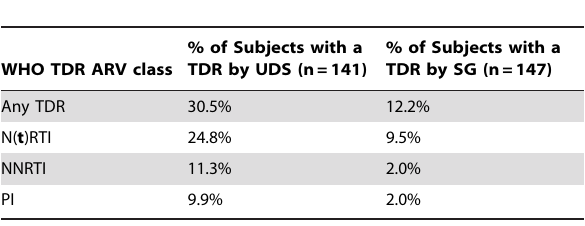
Table 2. Prevalence of transmitted drug resistance (TDR) mutations by Ultra-deep Sequencing (UDS) and by standard genotyping (SG).